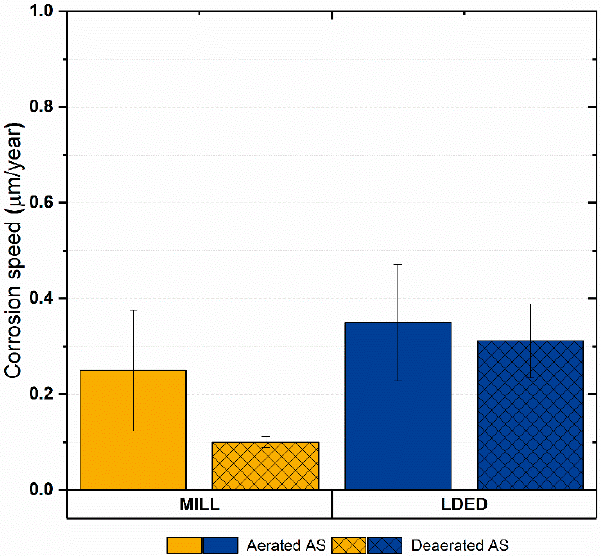
Figure 12. Bar graphs of equivalent corrosion rate (Ti) in aerated and deaerated artificial saliva. Error bars indicate the standard deviation.